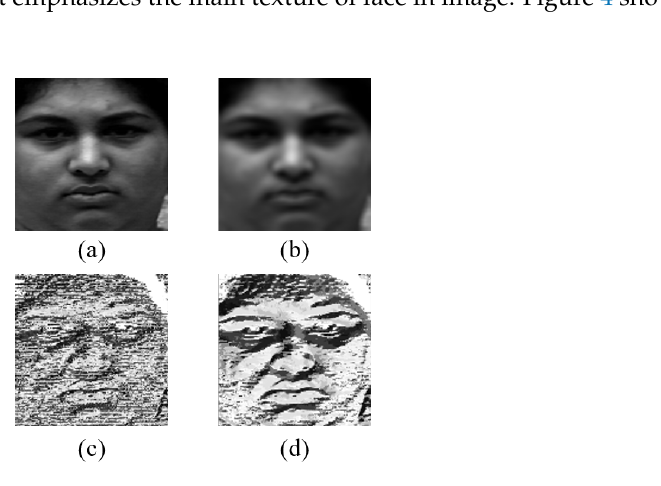
Figure 4. Feature extraction: ( a ) original image; ( b ) filtered image; ( c ) LBP feature without filtering; and ( d ) LBP feature with